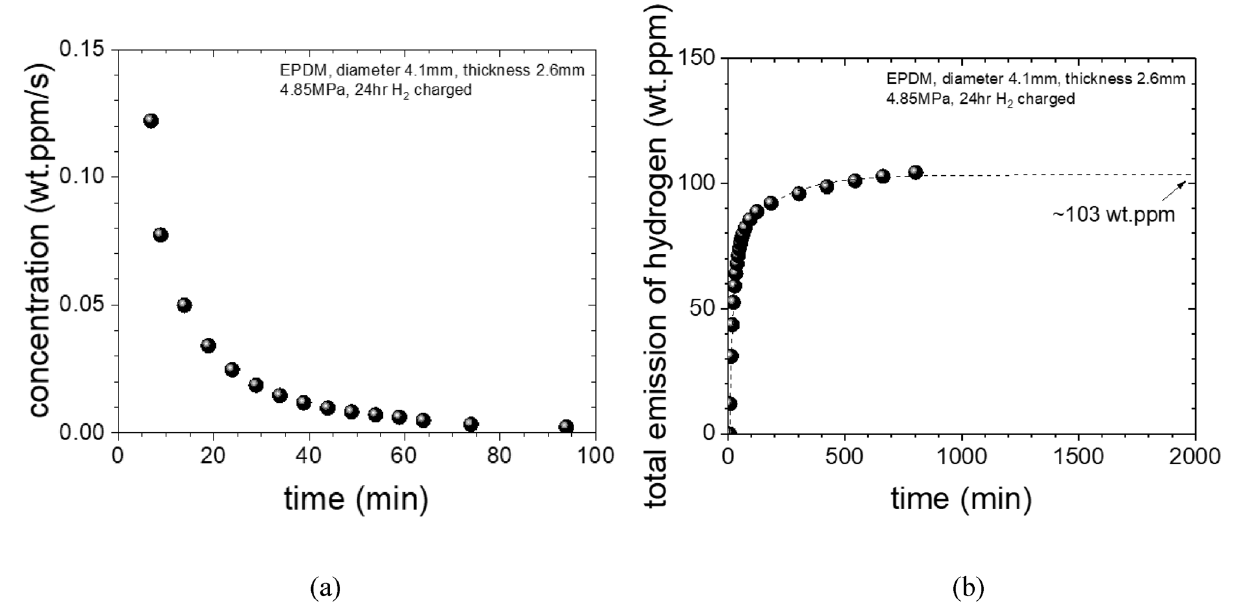
Figure 6. Time-dependent hydrogen concentration curve of an EPDM sample expressed in mass concentration versus time. ( a ) is transformed into mass concentration of hydrogen per second from the GC data in Fig. 5, ( b ) is the integration of the curve for ( a ) it gives us the saturation value, i.e. the total amount of the hydrogen charged into the EPDM sample. In this example, the extrapolated total hydrogen contents is 103